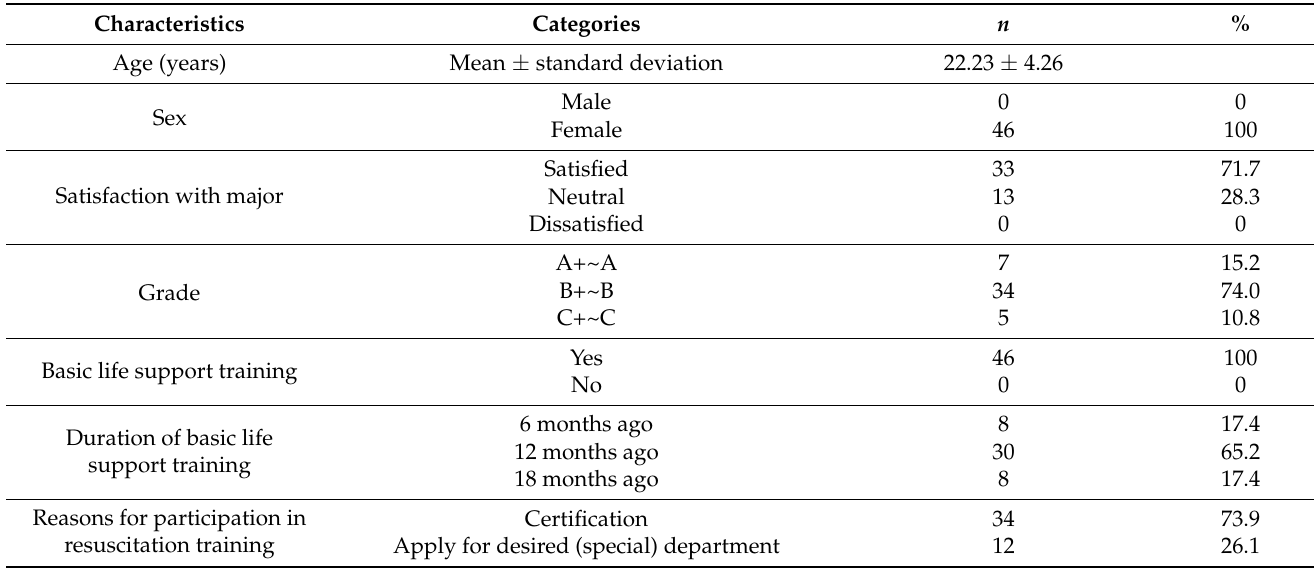
Table 2. General participant characteristics ( n = 46).